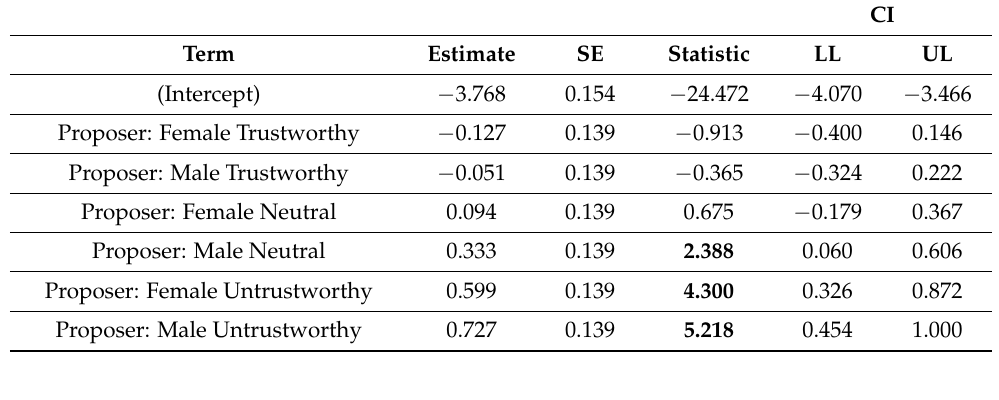
Table 1. Results of lmm on k parameter (log scale). Each coefficient is a contrast between the baseline and the condition. SE is the same for each level of proposer because the data are balanced. CI = 95%. LL = lower level. UP = upper level. Significant statistics (t as z criterion) are reported in bold.